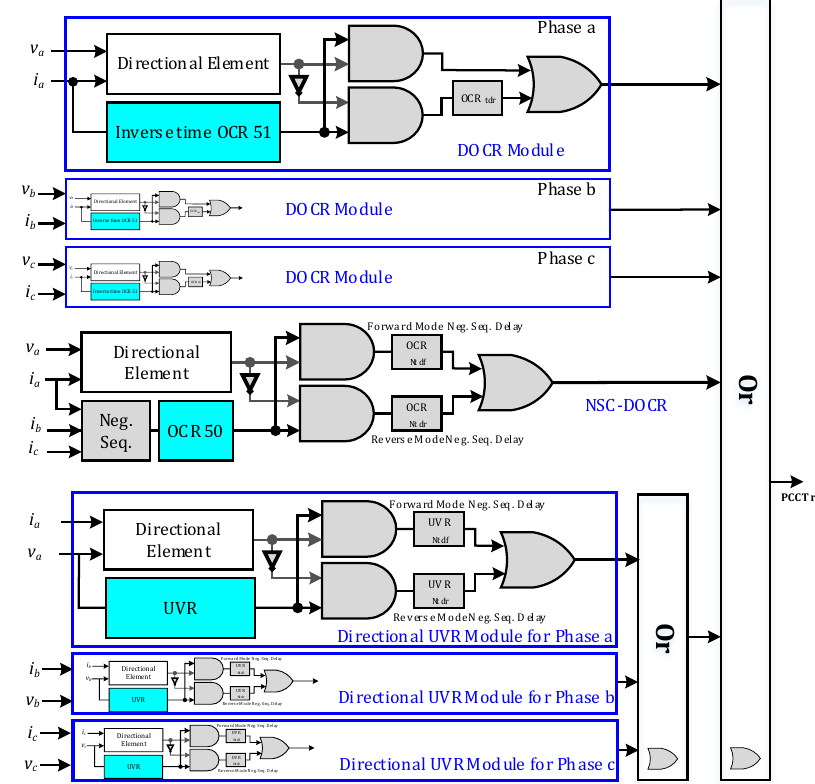
Figure 1. The proposed PCC protection